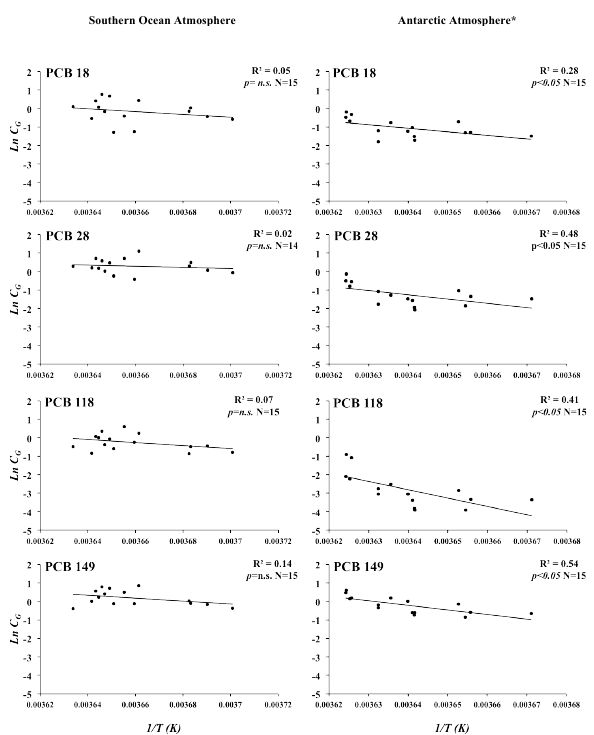
Fig. 6. Temperature dependence of atmospheric concentrations of PCBs. Natural logarithm of atmospheric gas phase concentrations concentration of PCBs (Ln C G , pgm − 3 ) versus inverse of air tem- perature (1/ T , K − 1 ) in the Southern Ocean Atmosphere (left pan- els) and in the Antarctic atmosphere at Livingston island (right pan- els). *Data taken from Cabrerizo et al.